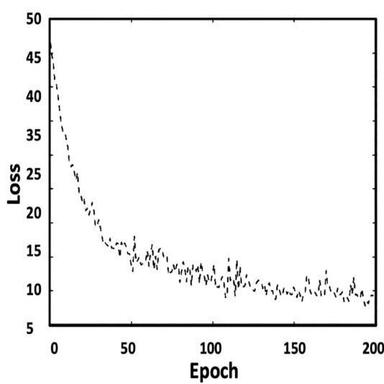
Generator's Training Loss function history log.